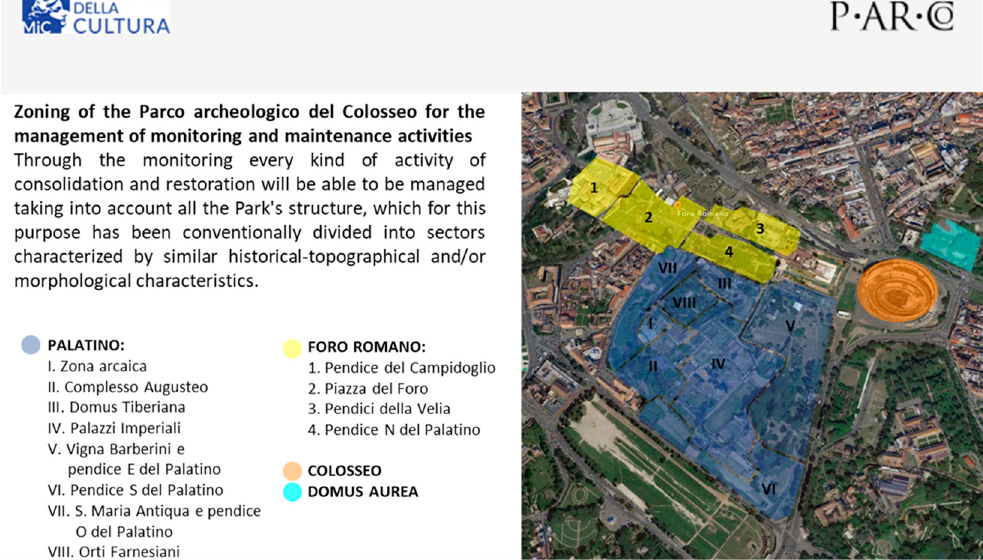
Figure 4. Zoning of the archaeological area for the management of monitoring and maintenance activities. Through monitoring, every kind of consolidation and restoration activity can be managed considering the whole Parco structure, which for this purpose has been conventionally divided into sectors characterized by similar historical-topographical and/or morphological features (figure produced with the kind collaboration by A.